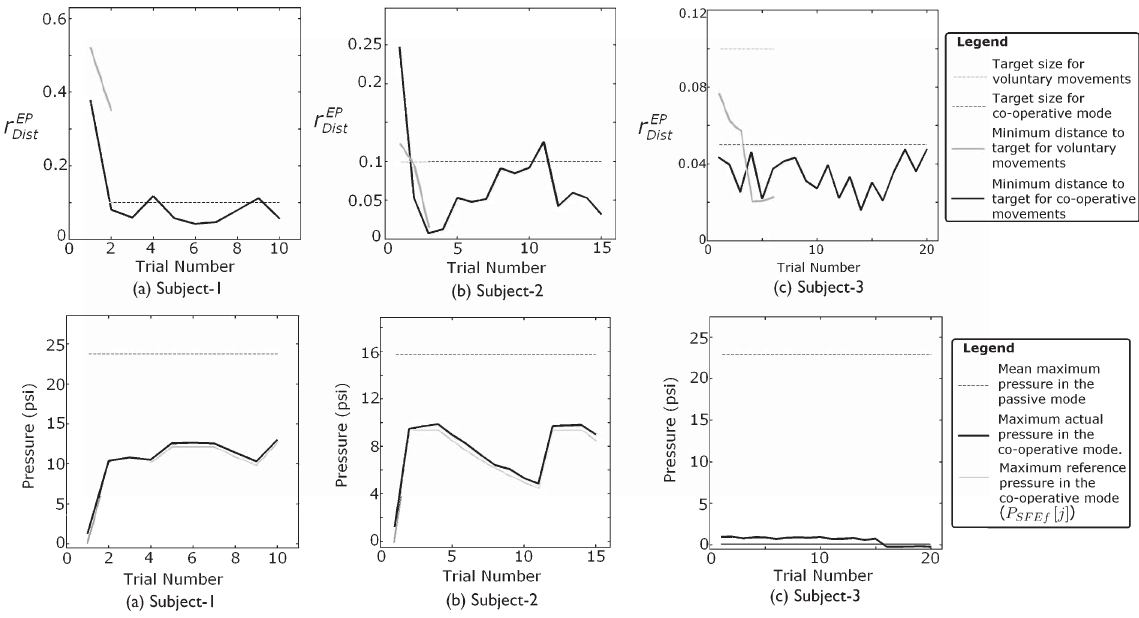
Fig. 8. Minimum distance to target for voluntary and ACM reaching movements to Target-2 (top row), and maximum shoulder PMA pressure for ACM reaching movements to Target-2 (bottom row) for all three stroke